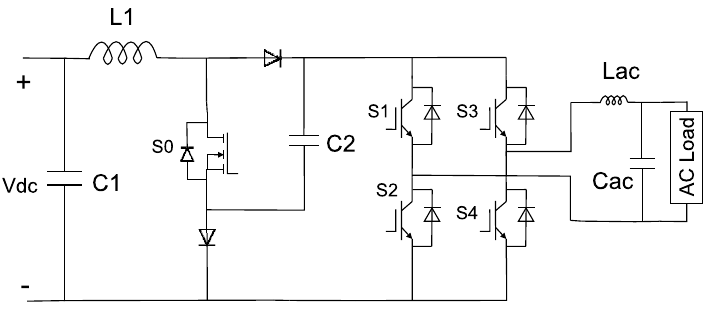
Figure 5. Active power buffer for CSI.